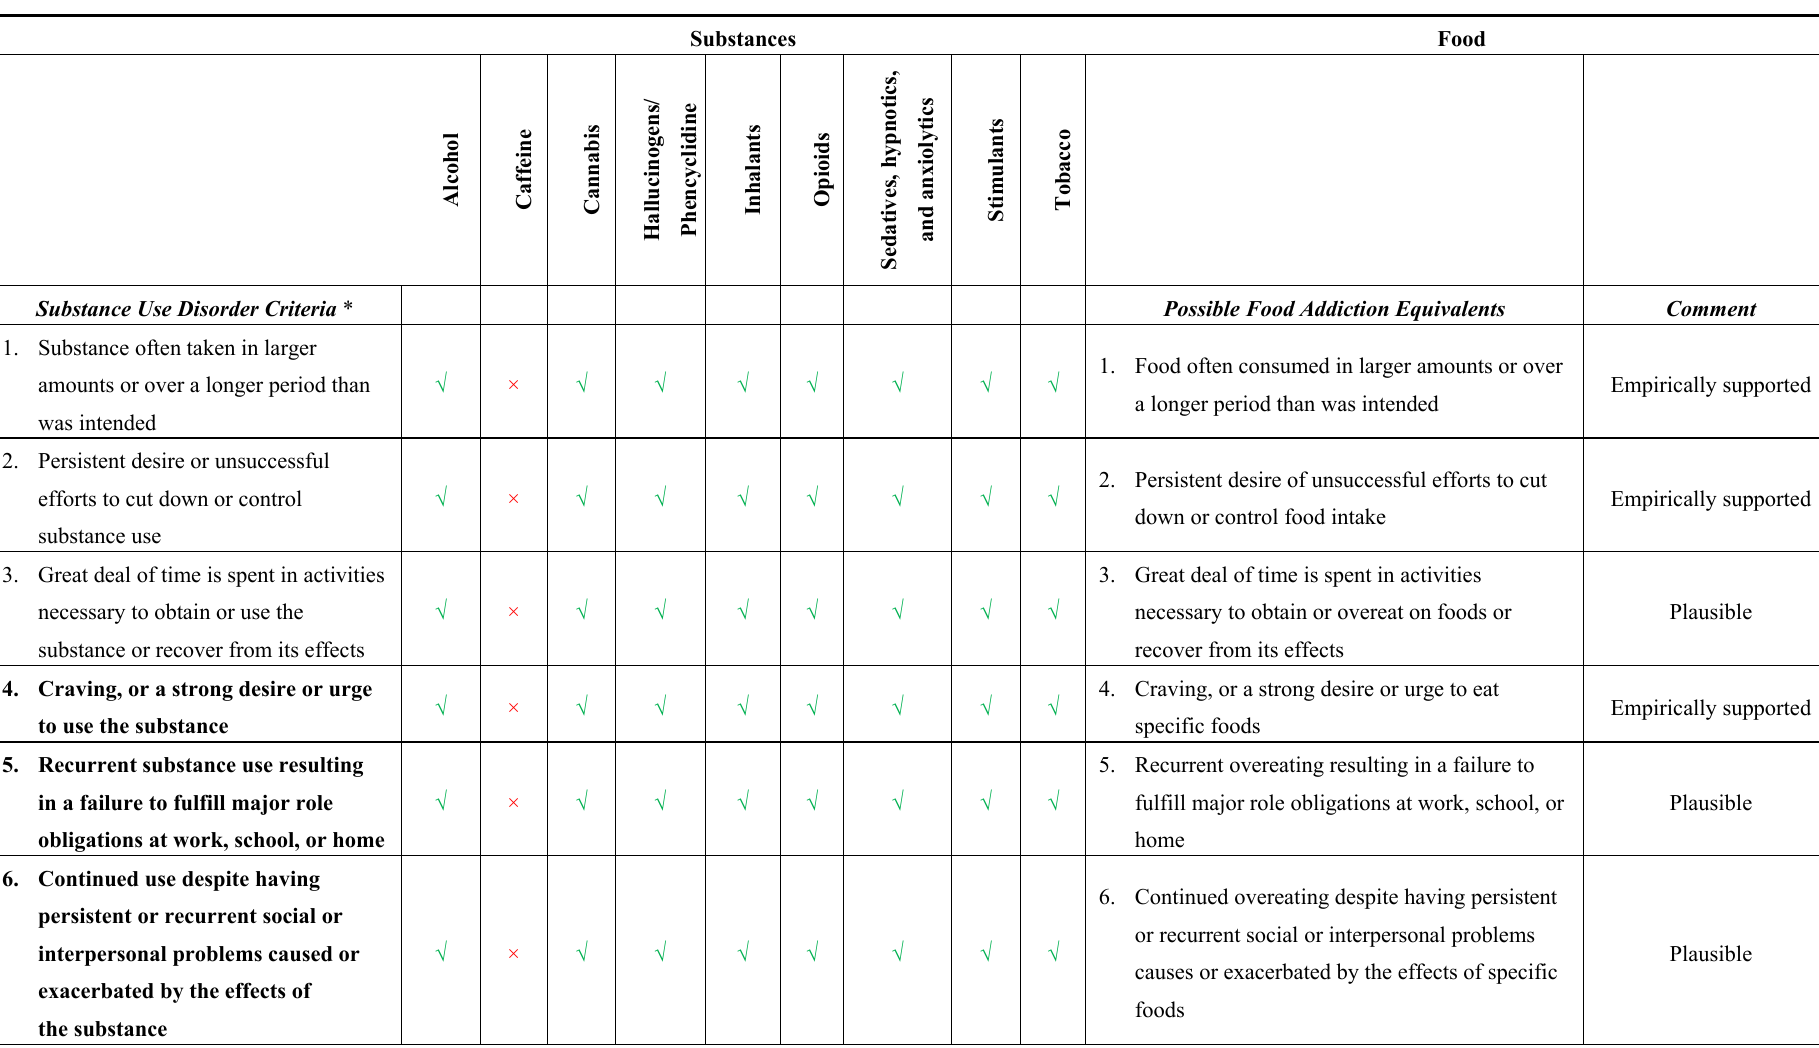
Table 1. Substance use disorder criteria according to the Diagnostic and Statistical Manual of Mental Disorders (DSM-5) and possible corresponding food addiction